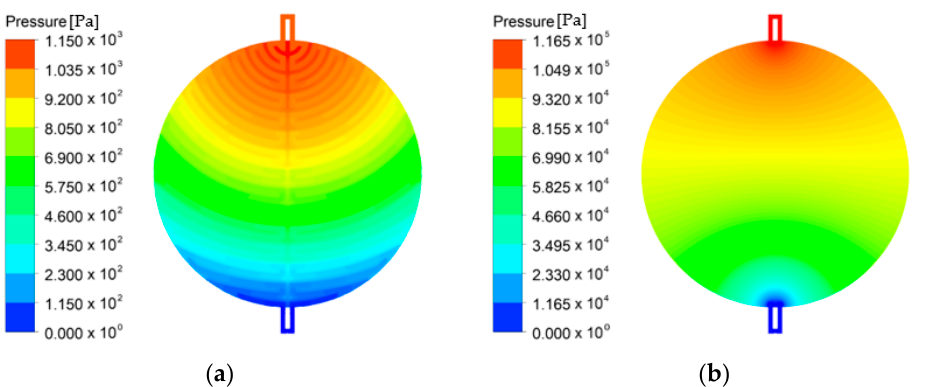
Figure 8. Pressure distribution inside the PEMWE cell using ( a ) the channel flow field and ( b ) the PTL flow field ( ε : 0.75, K : 30.2 × 10 −12 m 2 , θ : 30°, 𝑄̇ 𝑖𝑛 : 10 sccm, T in : 328.15 K, T cell : 328.15 K, V op : 1.8 V and 𝑔⃗ : z+).